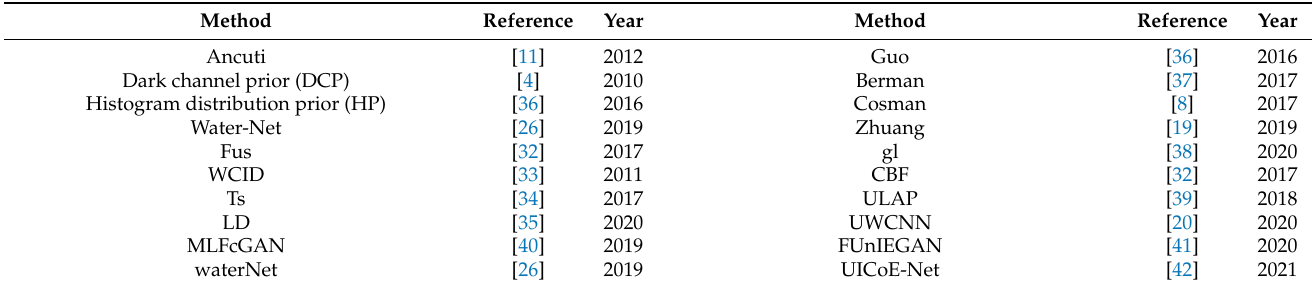
Table 1. Competitive methods used to compare the proposed algorithm.